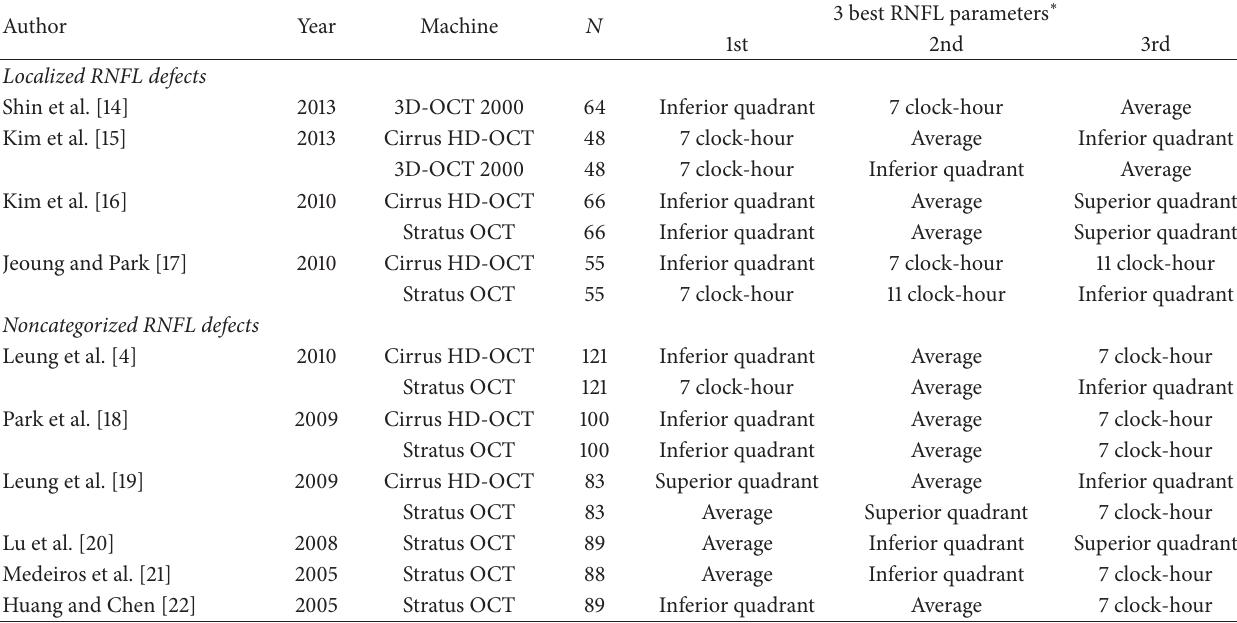
Table 4: Previous studies on the diagnostic ability of circumpapillary RNFL thickness for localized and noncategorized RNFL defects. Author Localized RNFL